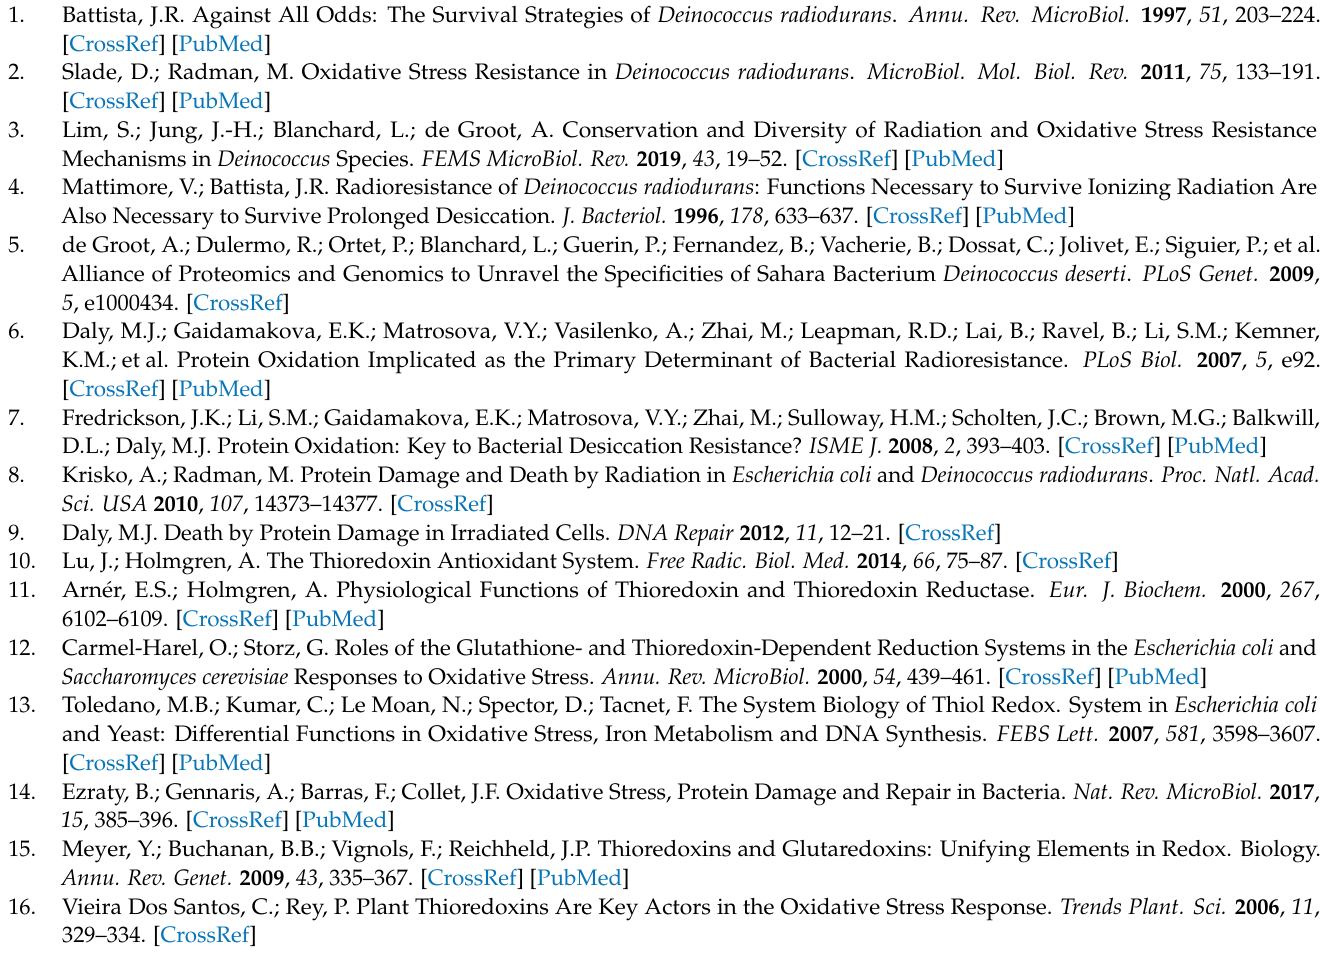
Figure S15: Multiple sequence alignment of Deinococcus bacillithiol reductases. Bdr homologs from Deinococcus are aligned with Bdr proteins YPDA_BACSU from B. subtilis , BC_1495 from B. cereus , and SACOL1520 from S. aureus . Cysteine residues are highlighted in yellow. Figure S16: Multiple sequence alignment of Deinococcus bacilliredoxins. The BrxC-type bacilliredoxins (also called AbxC for atypical BrxC) from Deinococcus are aligned with BrxC proteins YtxJ_BACCE from B. cereus , YTXJ_BACSU from B. subtilis , and SACOL0804 from S. aureus . Active site cysteine is highlighted in